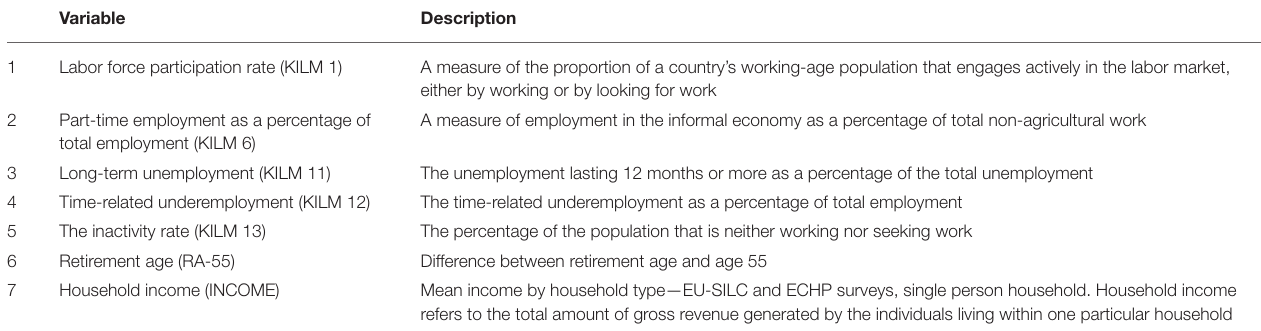
TABLE 1 | Explanatory variables—selected indicators of the labor market. Variable